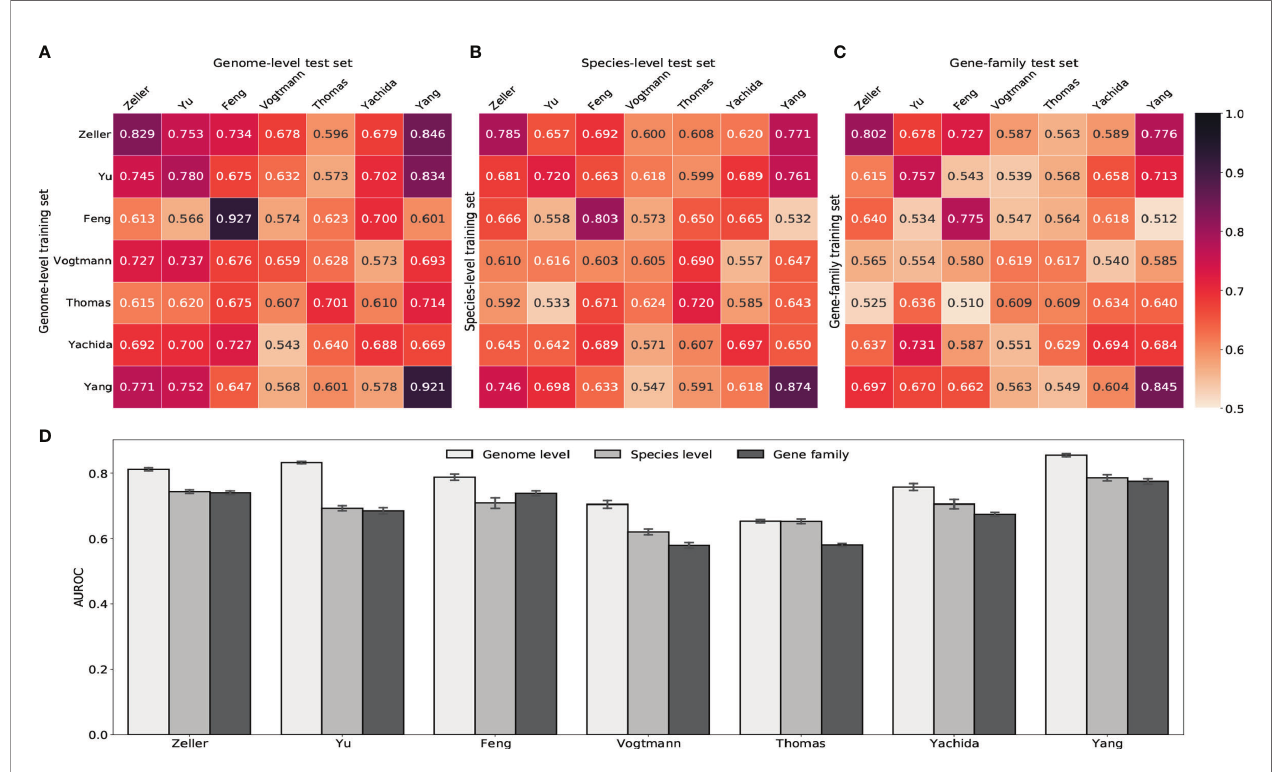
FIGURE 5 | Prediction performances of random forest classi fi ers based on gut viral abundance. (A) Within and cross study AUROC matrix obtained by using GPD genome-level abundance. The diagonal refers to results of cross validation within each dataset. Off-diagonal values refer to prediction results trained on the study of each row and tested on the study of each column. (B) Within and cross study AUROC matrix obtained by using species-level abundance. See Supplementary Figures S12A, B for genus-level and family-level AUROC. (C) Within and cross study AUROC matrix obtained by using gene-family abundance. See Supplementary Figure S12C for pathway AUROC. (D) LODO results with the x axis indicating the study left out as the validation set and other studies combined as the training